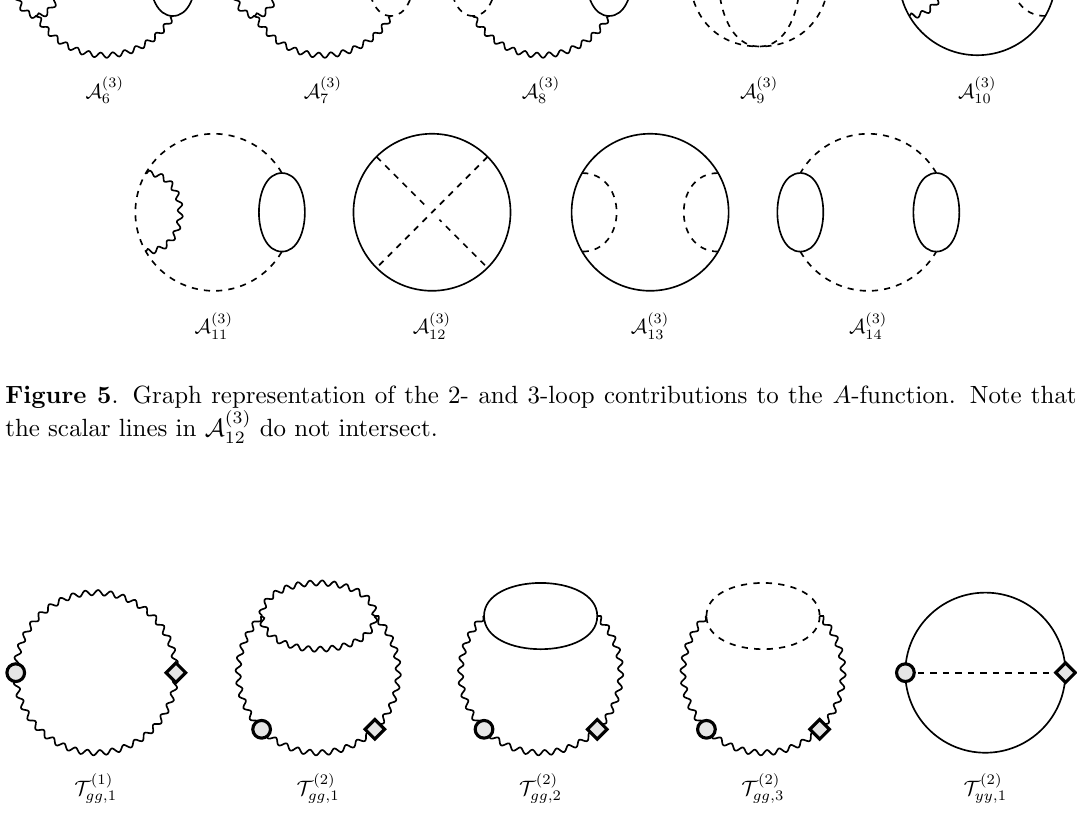
IJ . A circle indicates an